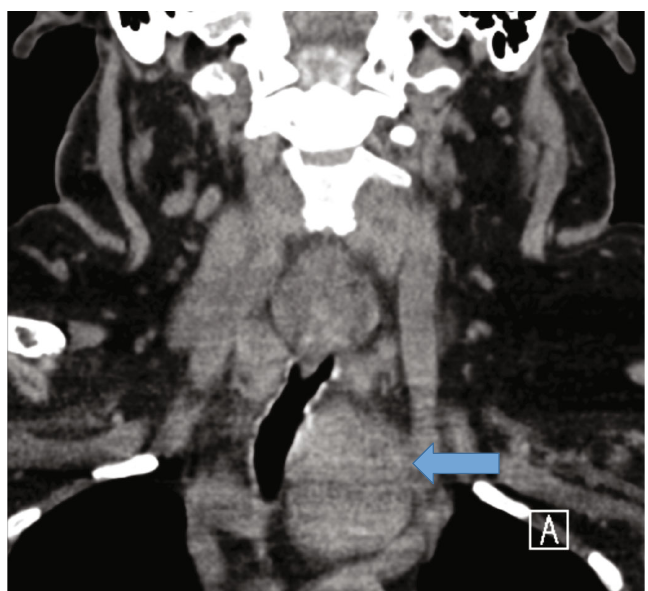
Figure 4: Coronal view of CT neck showing a substernal anterior mediastinal exophytic mass (blue arrow) found to be a benign thyroid mass by US-FNAC measuring 9 × 4 × 3